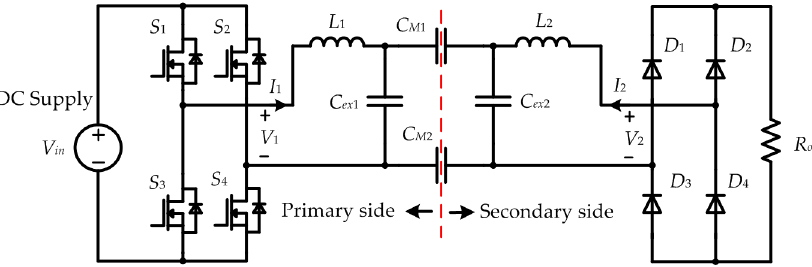
Figure 16. Circuit topology of a CPT system based on full-bridge inverter with double-sided LC compensation.